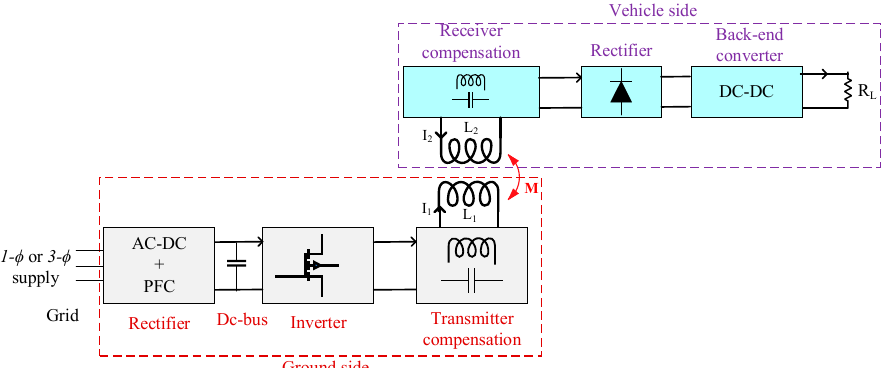
Figure 1. Simplified block diagram of an exemplary IPT system.